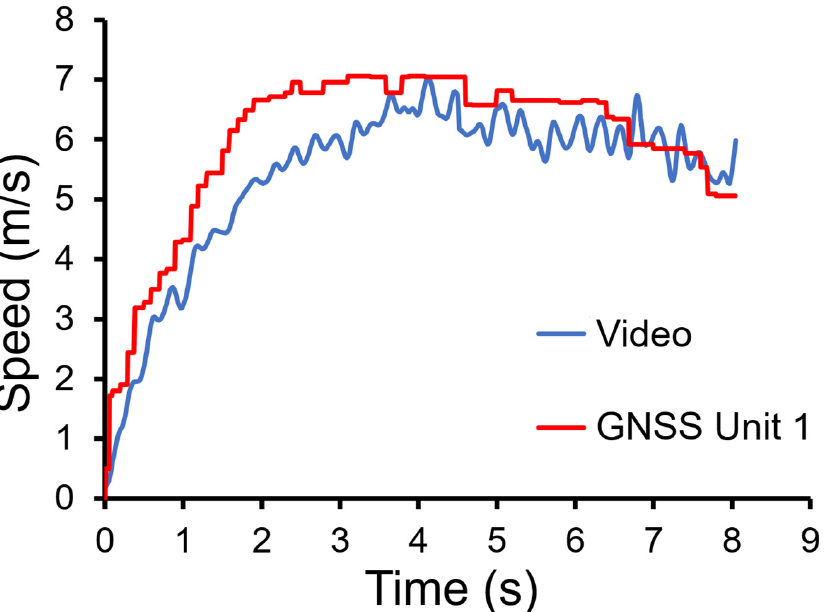
Figure 3. Representative raw speed-time from one participant measured using Kinovea video analysis and one GNSS unit.